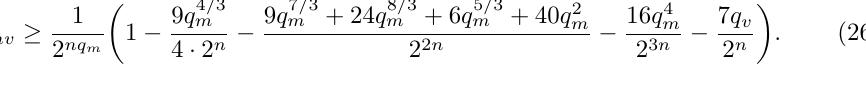
Figure 6.1: (a) star type component, (b) the component with a single edge and (c) component with a path of length